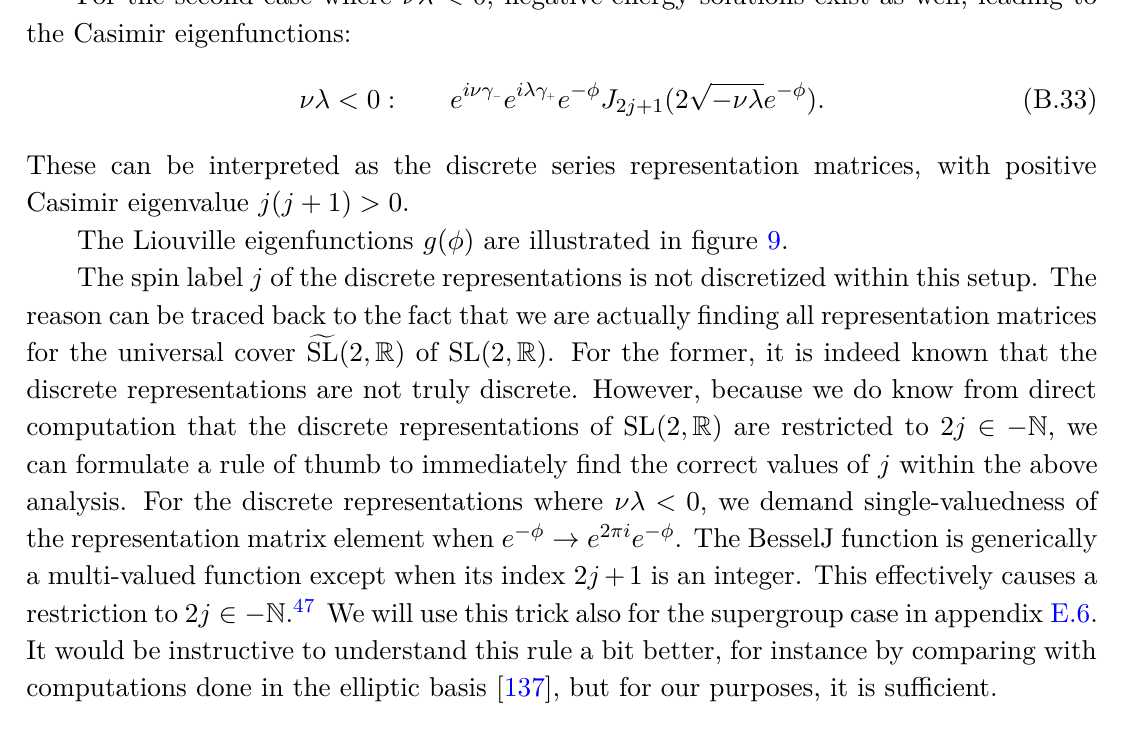
all of which have positive energy k 2 (and negative Casimir eigenvalue − 1 / 4 − k 2 ).